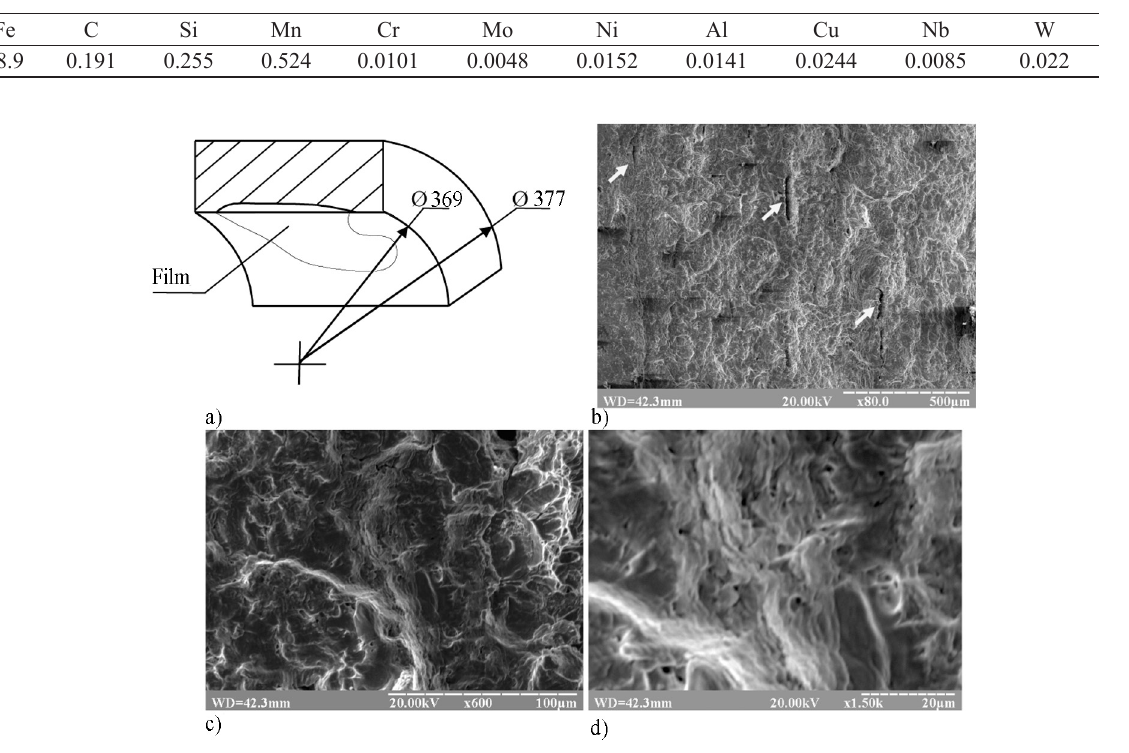
Fig. 5. Film fracture surface (а) and micromechanisms of its fracture (b, c) (hydrogen delamination is indicated